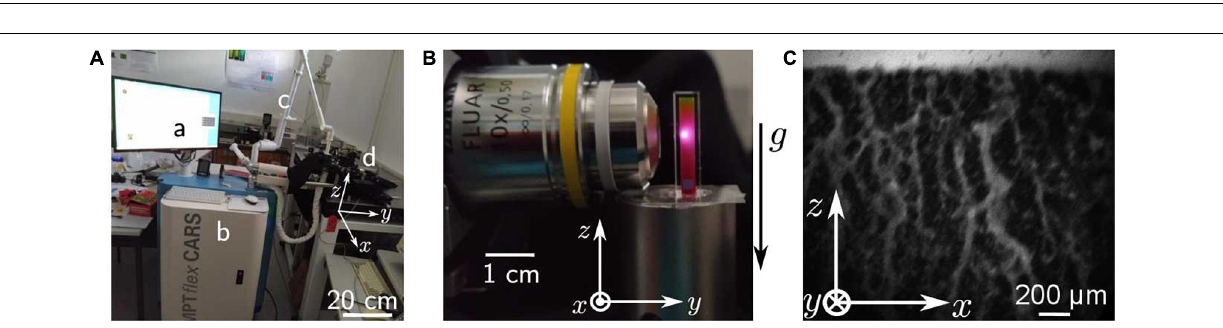
FIGURE 1 | Mesoscopic blue-light transmission observation. (A) Picture of the whole set-up with (a) the blue light source, (b) the sample, (c) the microscope connected to (d) the camera and (e) the computer. (B) Scheme of the microscopy set-up and the sample structure. (C) Picture of the whole sample, as obtained from a regular camera with macroscopic objective. The picture has been obtained after 90 min sedimentation time. (D) Microscopic picture obtained with blue light transmission after 30 min sedimentation time (wide view). Bright areas are the ones where no cells are observed along the y axis, since erythrocytes absorb the transmitted blue light.